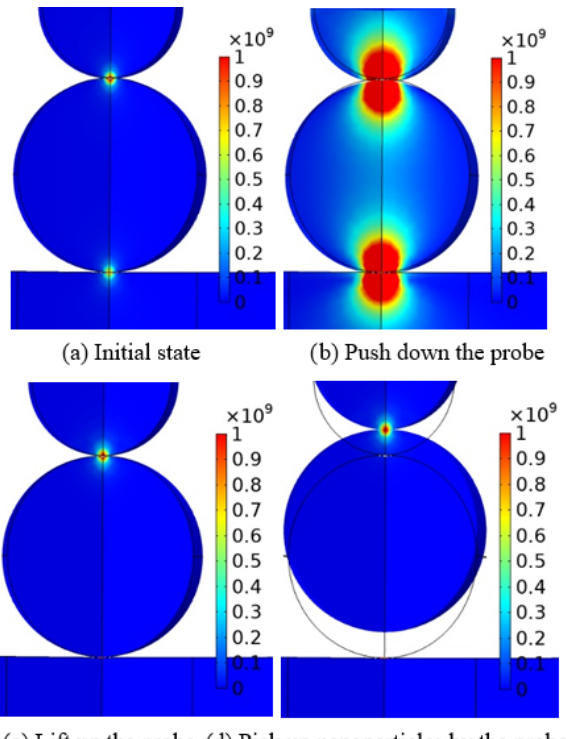
Figure 4. Process diagram of probe picking up